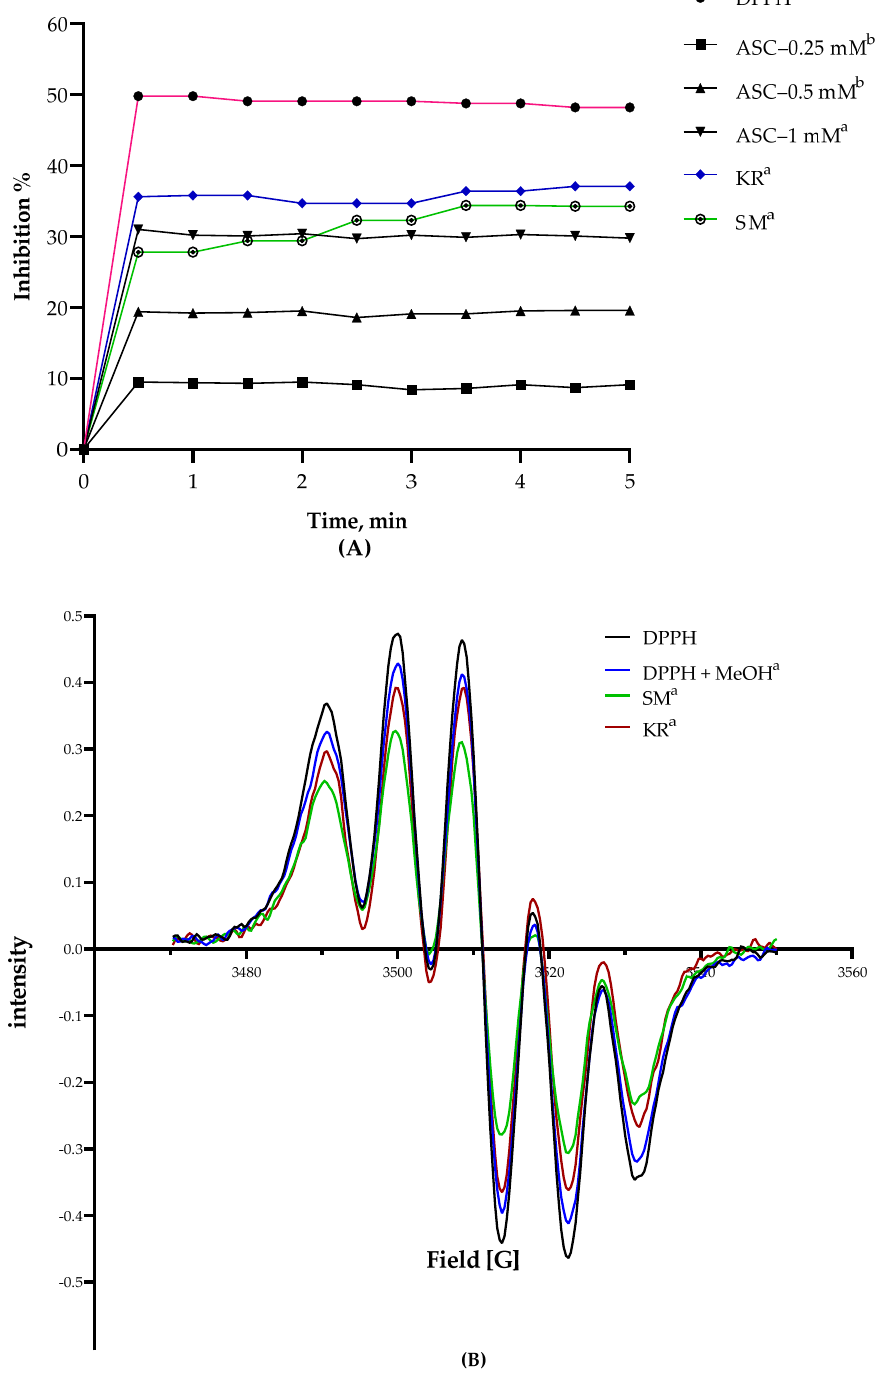
Figure 4. Inhibition percentage of kudzu roots (KR) and soy molasses (SM) extracts compared to standard ascorbic acid (ASC). DPPH for quantifying the intensity and ascorbic acid equivalency ( A ), and EPR spectra ( B ) of DPPH in different environments. Data are shown as mean ± SD. a,b Means that do not share the same letter in each column are significantly